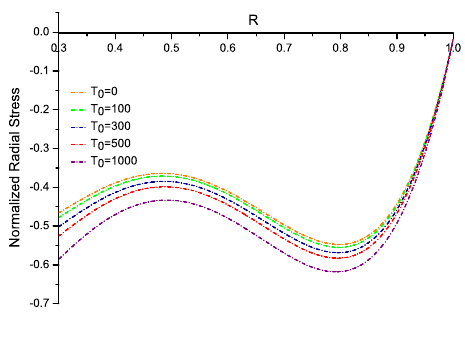
Figure 3–5 represents normalized stresses (normal- ized radial stress, normalized circumferential stress and normalized axial stress) for different values of material